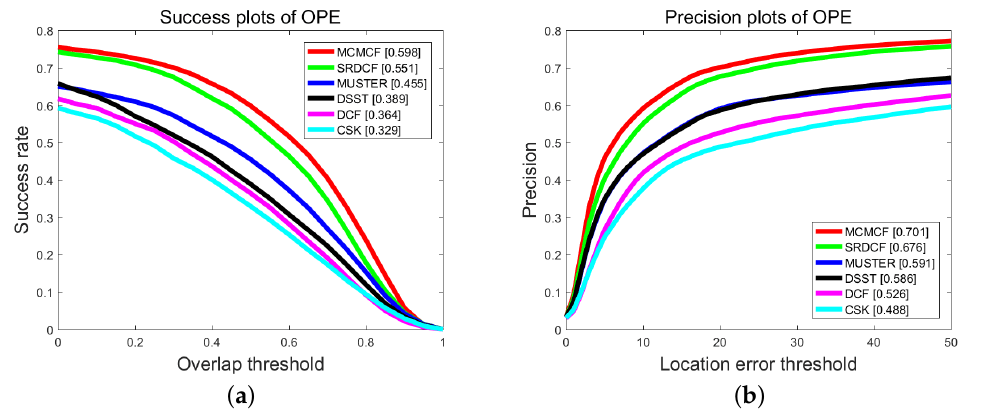
Figure 7. Comparison of success rate and accuracy with similar trackers on the UAV123 based dataset: ( a ) success result for models; ( b ) precision result for models.